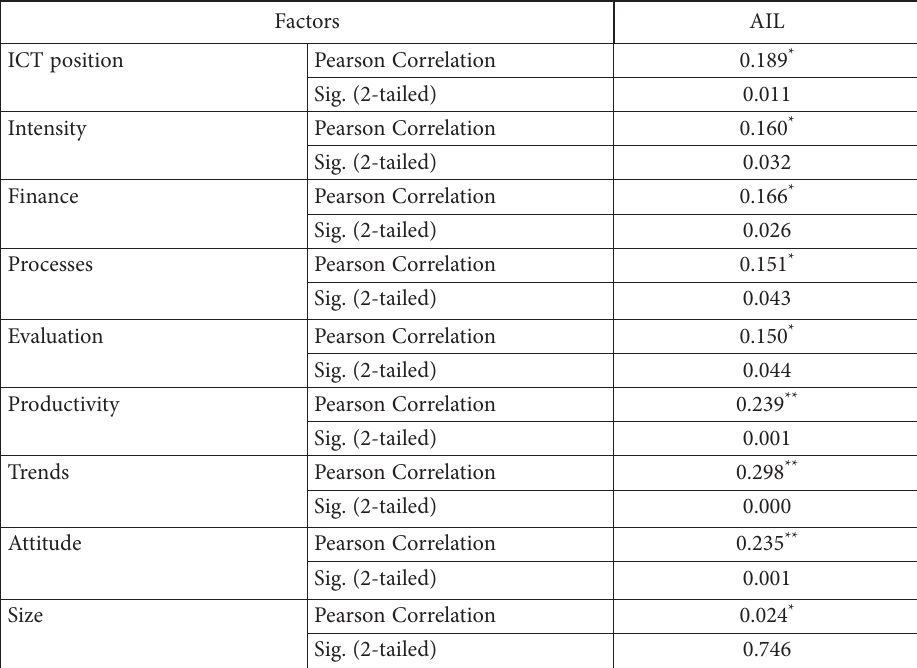
Table 3. Results of the correlation analysis (source: own